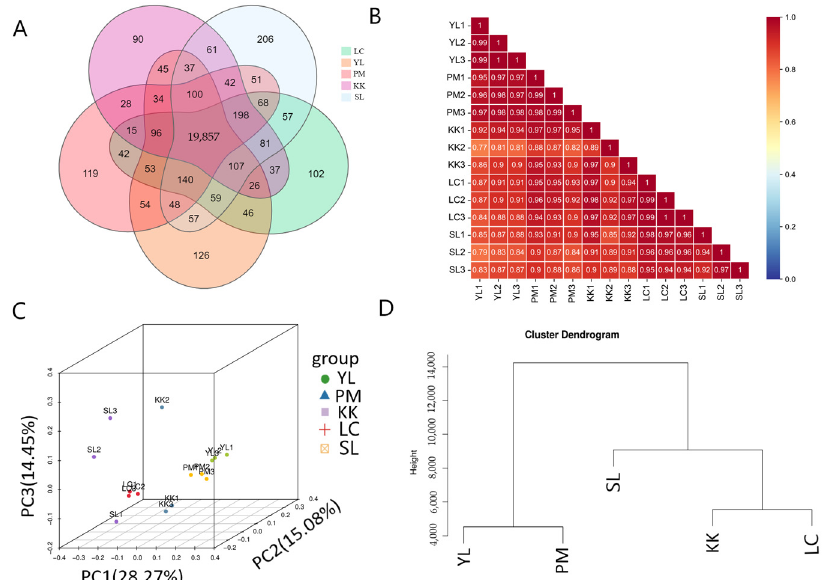
Figure 2. ( A ) Venn diagram of all unigenes in five stages; ( B ) module-sample correlation heat map; ( C ) principal component analysis (PCA) of all samples based on 16,600 genes (FPKM value ≥ 1); ( D ) hierarchical clustering analysis (HCA) of all groups (based on the average FPKM data of three replicate samples per group).